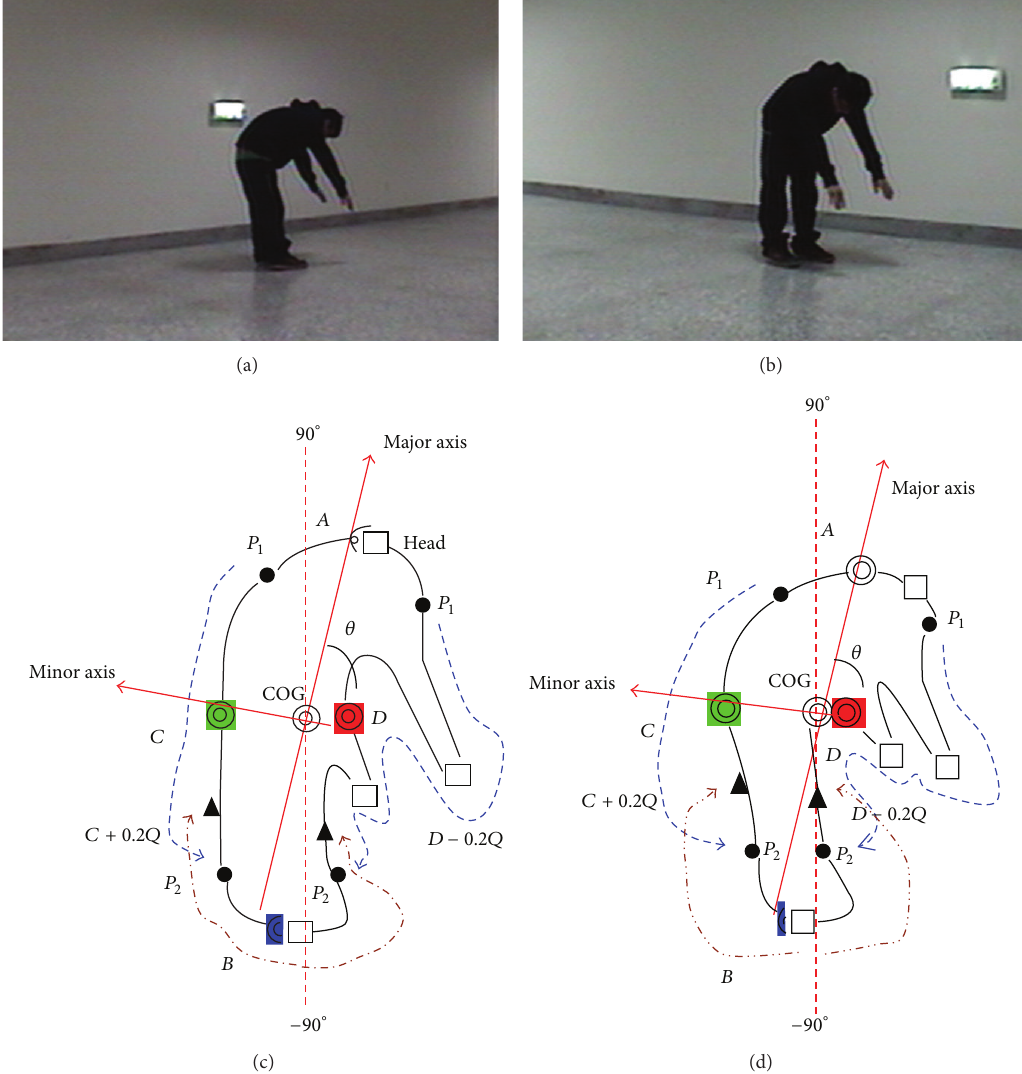
Figure 3: (a) and (b) Original images. (c) and (d) Orientation of the body, directions of the major and minor axes found, their intersection with the body contour, the contour convex points found, and the search regions of the tips of the hands and the feet.